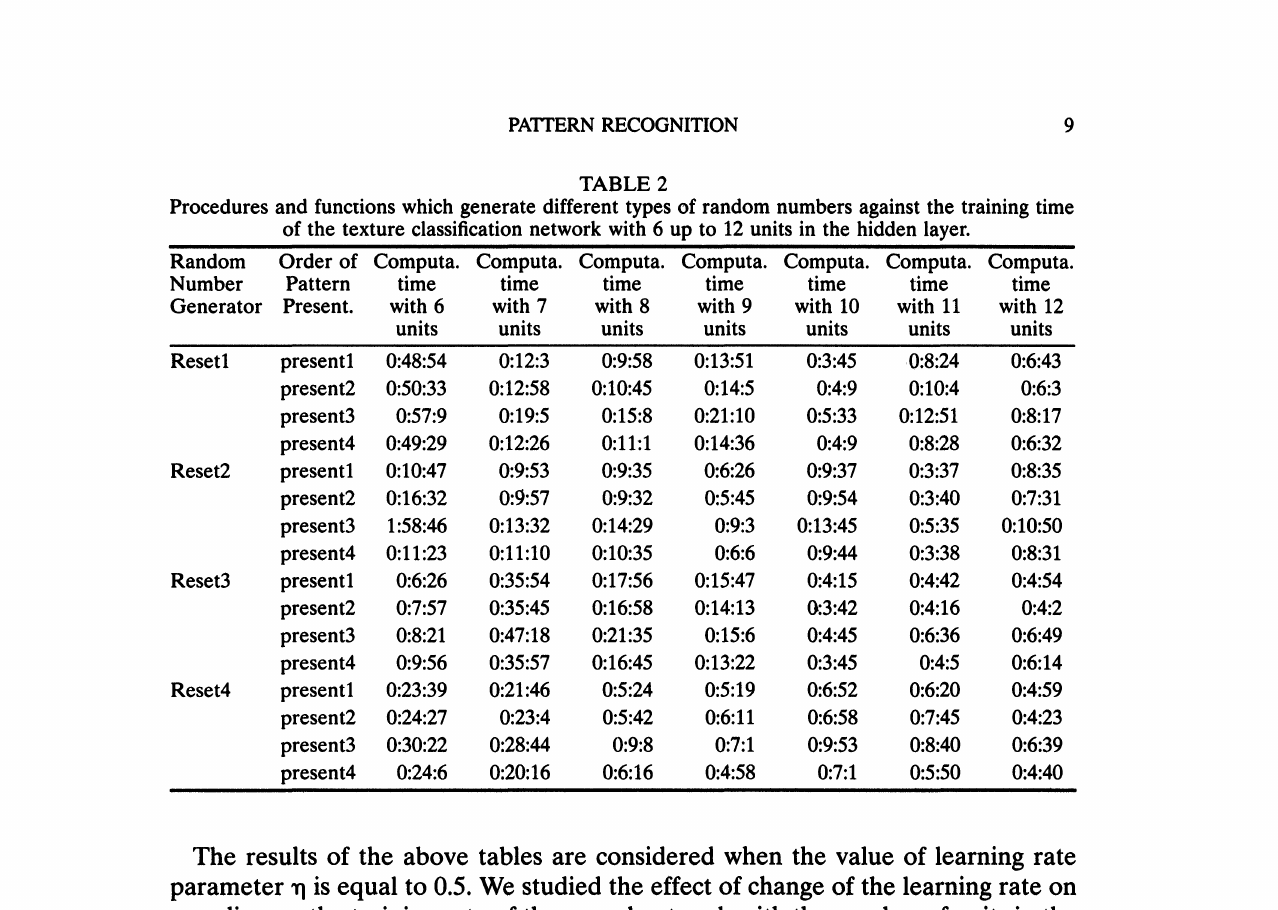
TABLE 3 Results of actual defects on H.V. insulating